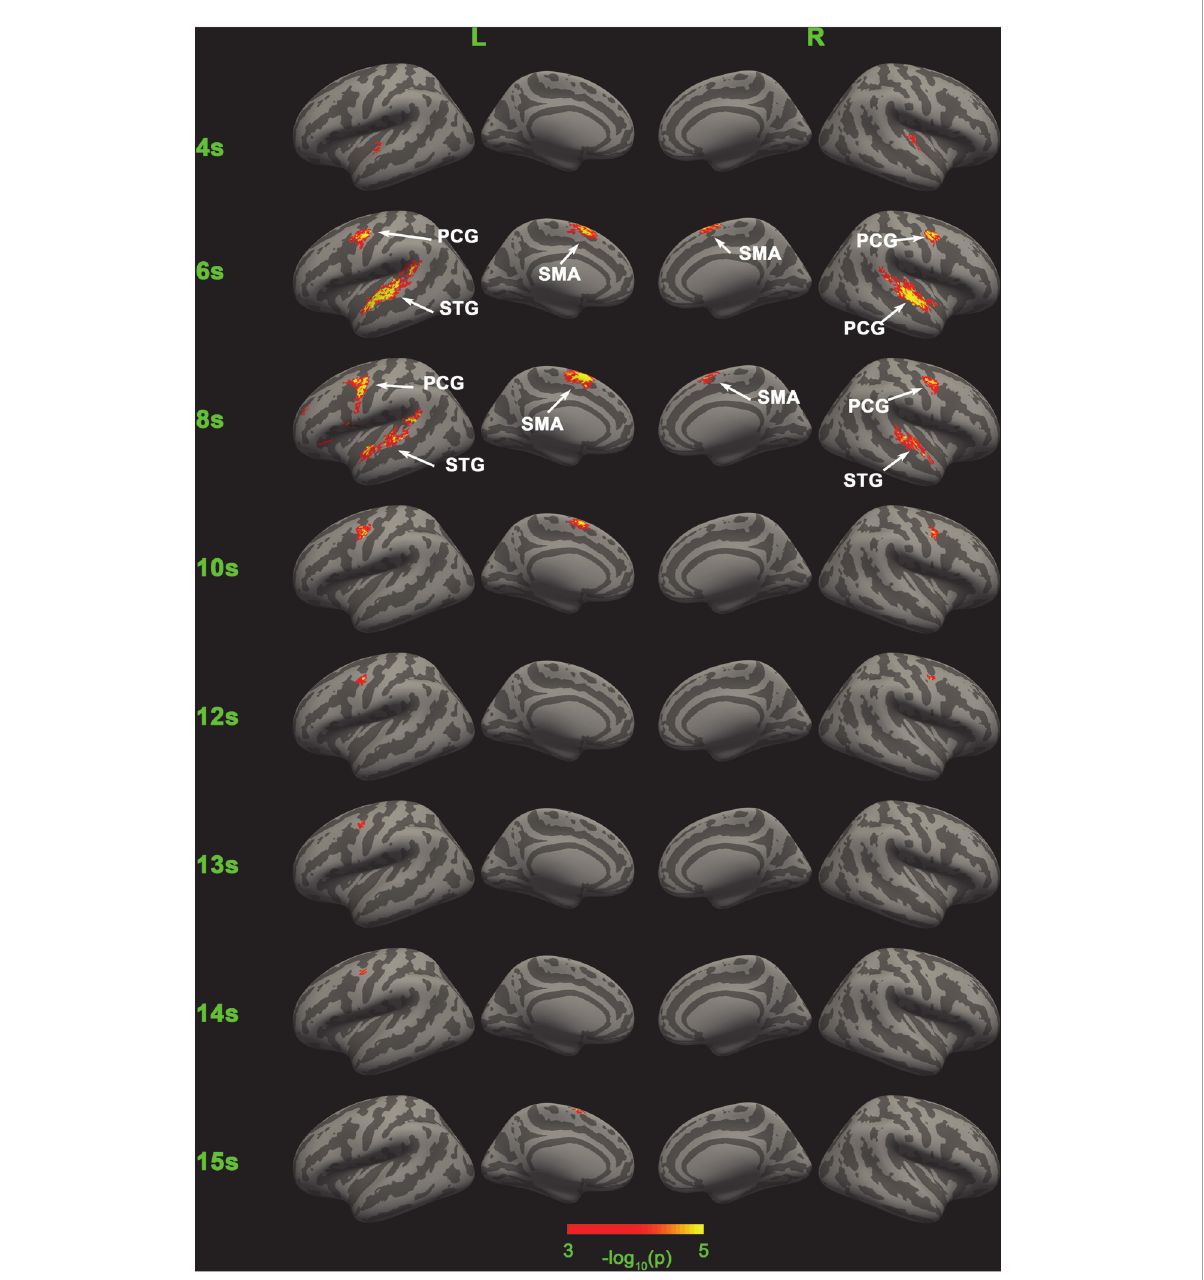
FIGURE5 Significance of the classification of the five categories of SC-MVPA. The neural coding of the five conditions are distinguishable in bilateral STG in 4, 6, and 8 s, in left SMA in 6, 8, 10, and 15 s, in right SMA in 6 and 8 s, in left PCG in 6, 8, 10, and 12 ∼ 14 s, and in right PCG in 6, 8, 10, and 12 s.